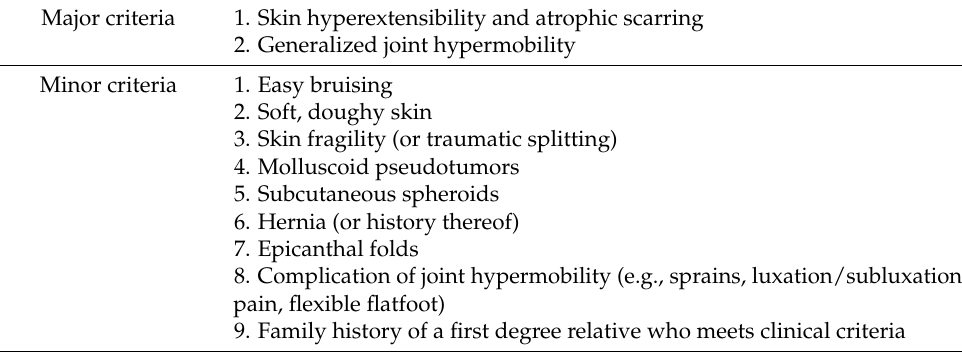
Table 3. Classical EDS clinical criteria in humans, adapted from